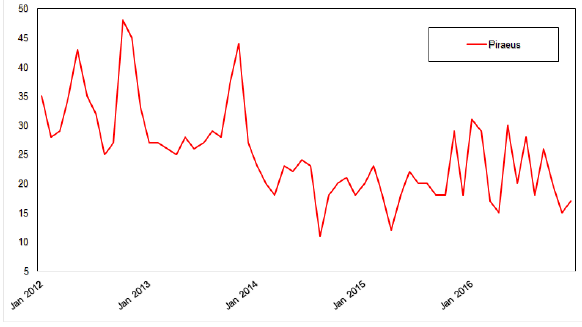
Figure 8 Variation of counted AIS’ positions per bin in Piraeus port location (2012-2016).